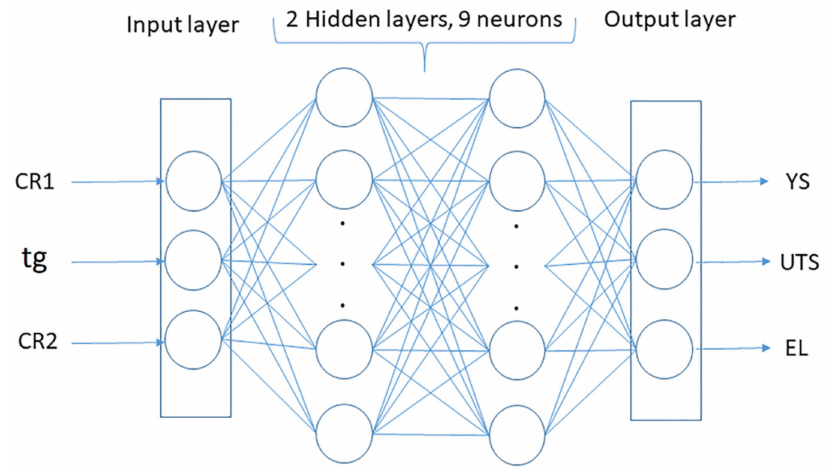
Figure 2. Configuration of the artificial neural network (ANN) model.